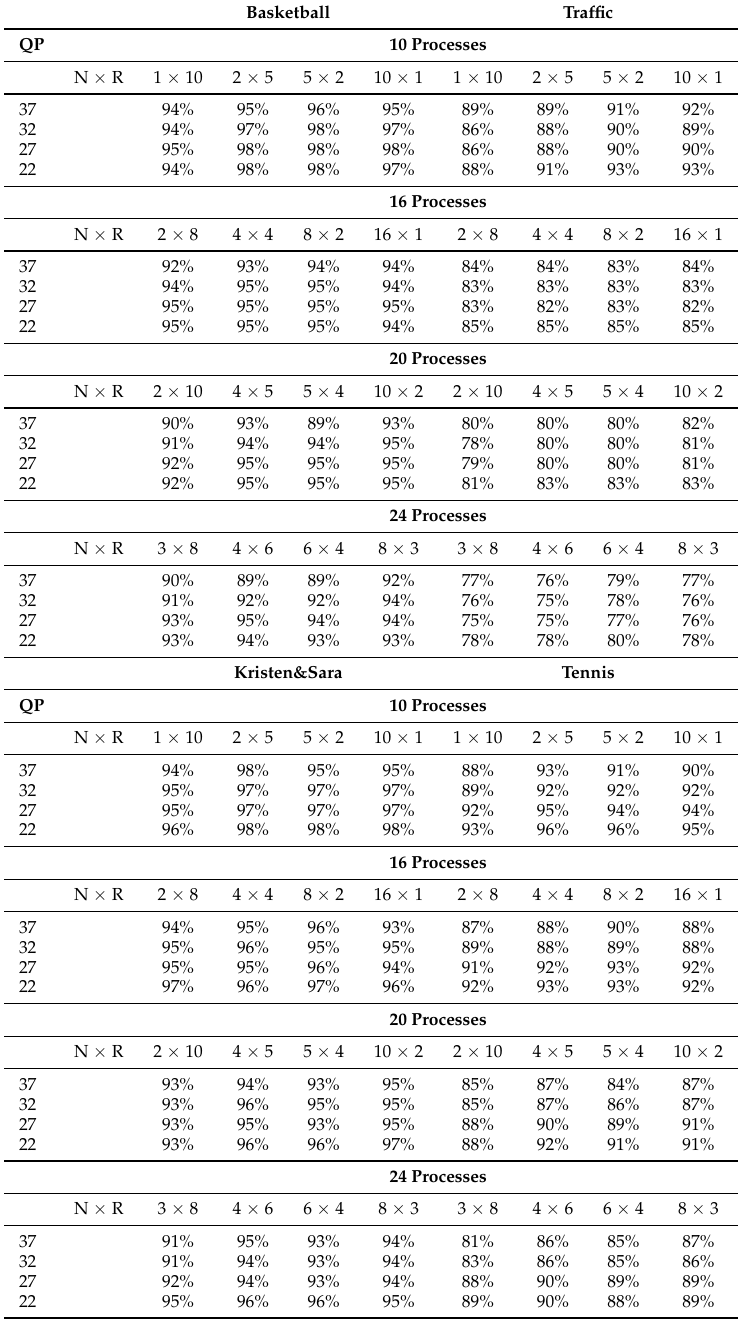
Table 8. Efficiency of the DMG-AI parallel